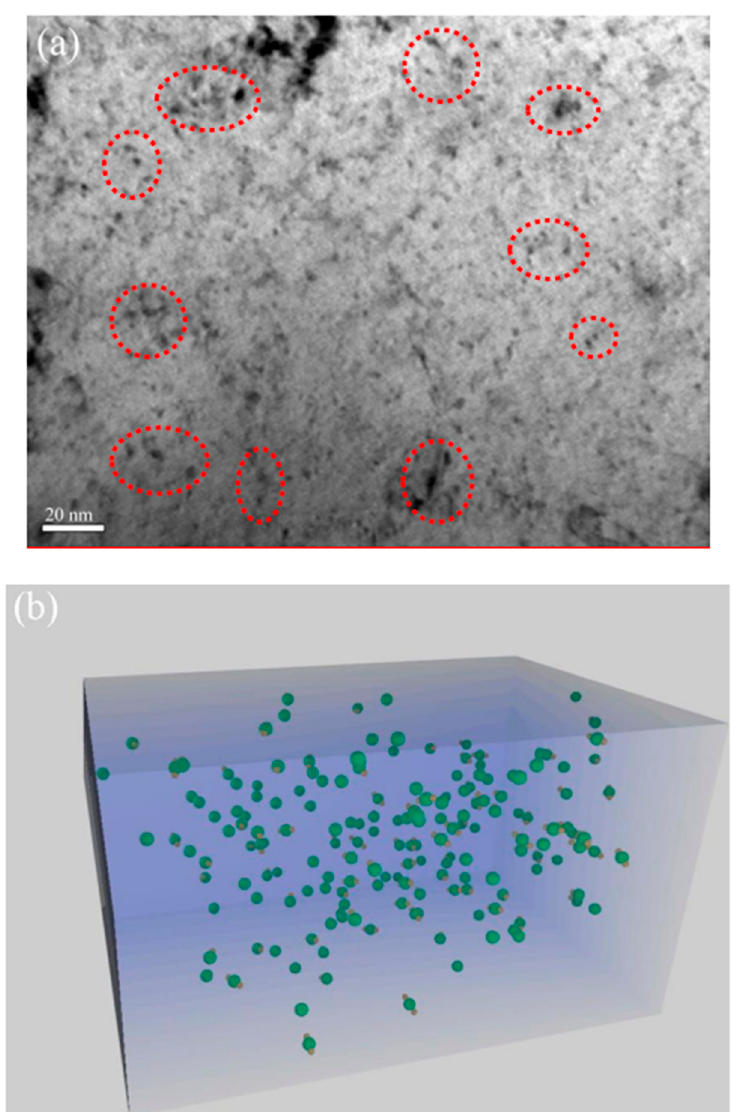
Figure 12. TEM micrographs of in situ nanoparticles in N1 steel and the model of the adsorption of Cl - by in situ nanoparticles: ( a ) TEM bright-field image; ( b ) the green spheres represent the in situ nano phase and the orange spheres represent Cl - .